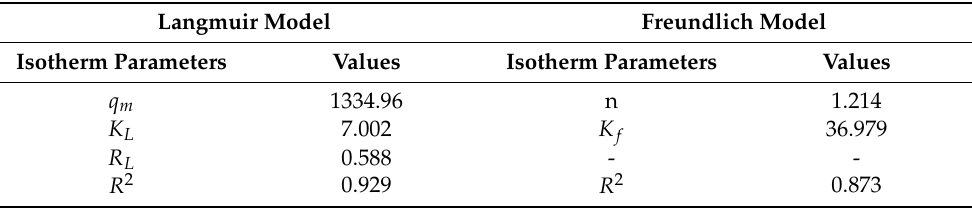
Table 1. Langmuir and Freundlich models parameters recovered for Fe 3 O 4 NPs @APTES. Langmuir